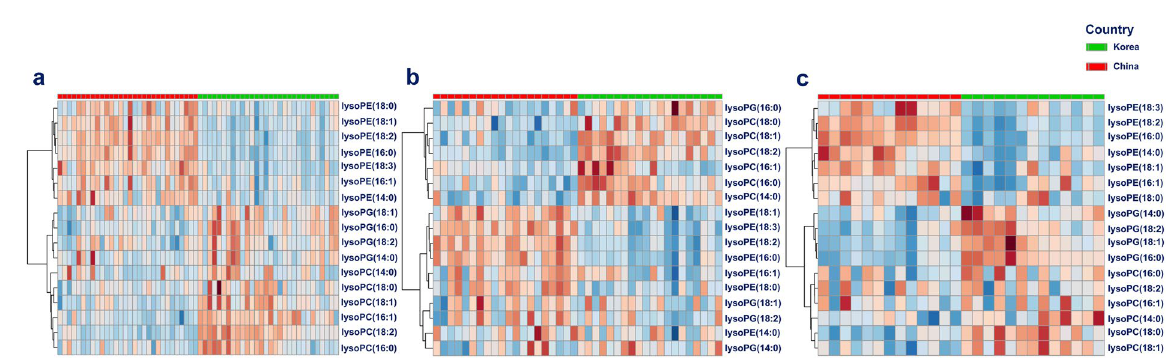
Figure 2. PAM and PCA analyses for data exploration. (a–c) Show two clusters of PAM of 2014 white rice, 2015-early white rice, and 2015-late white rice, respectively. (d – f) Show PCA biplots of 2014 white rice, 2015- early white rice, and 2015-late white rice, respectively. ( a ) 1–30: white rice from Korea, 31–60: white rice from China. ( b ) 1–20: white rice from Korea, 21:40: white rice from China. (c) 1–13: white rice from Korea, 14–26: white rice from China.